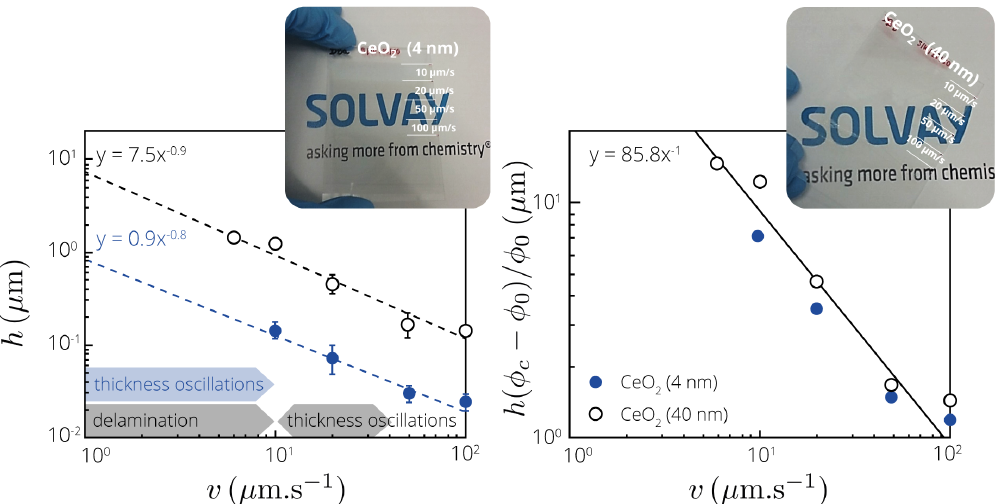
Figure 1. ( Left ): Thickness of coatings of CeO 2 nanoparticles deposited at different coating speeds v ; each point averages at least seven independent experiments. The different morphologies of the sample are zoned at the bottom left for the two systems (blue 4 nm, grey 40 nm) and flat films are obtained otherwise, see Figure 2 top; the dashed lines represent the fitting with a power law. ( Right ): Rescaled data considering the initial volume fraction φ 0 and a dry volume fraction φ c = 0.61. The solid line is a fit according to Equation (3). Inserts: Macroscopic views of the samples highlighting the high degree of